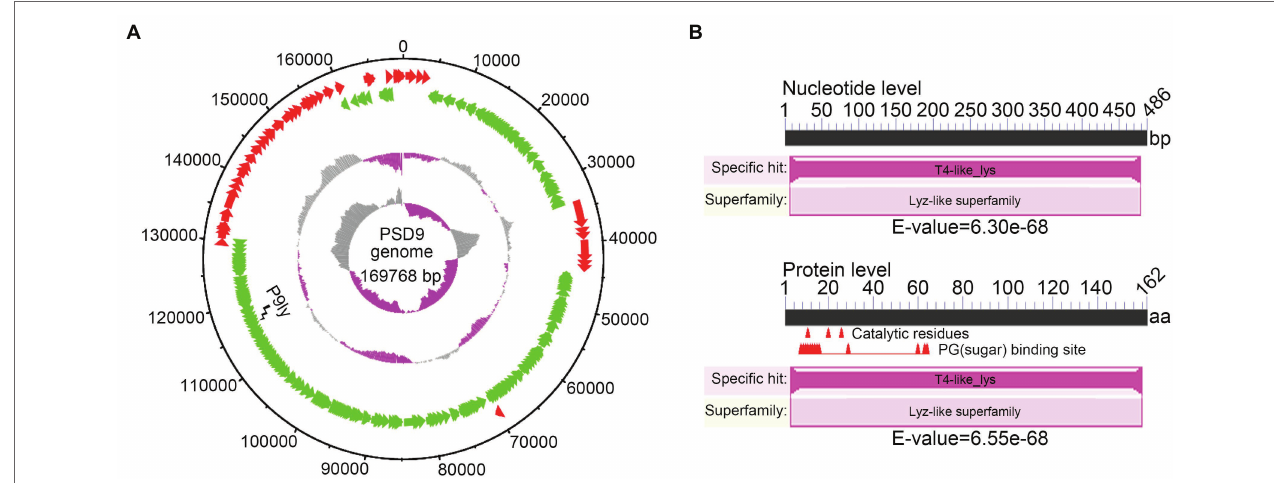
FIGURE 1 | Whole-genome sequencing of bacteriophage PSD9 was carried out to identify the lytic enzyme P9ly encoded by it. (A) Bacteriophage PSD9 genome map. The inner to outer circles are as: GC skew [(G − C)/(G + C)]; GC content percentage; negative strand open reading frames (ORFs; shown in green); positive strand ORFs (shown in red); and genome size (with an interval of 10 kb). (B) Conserved domain analysis of P9ly at nucleic acid and protein